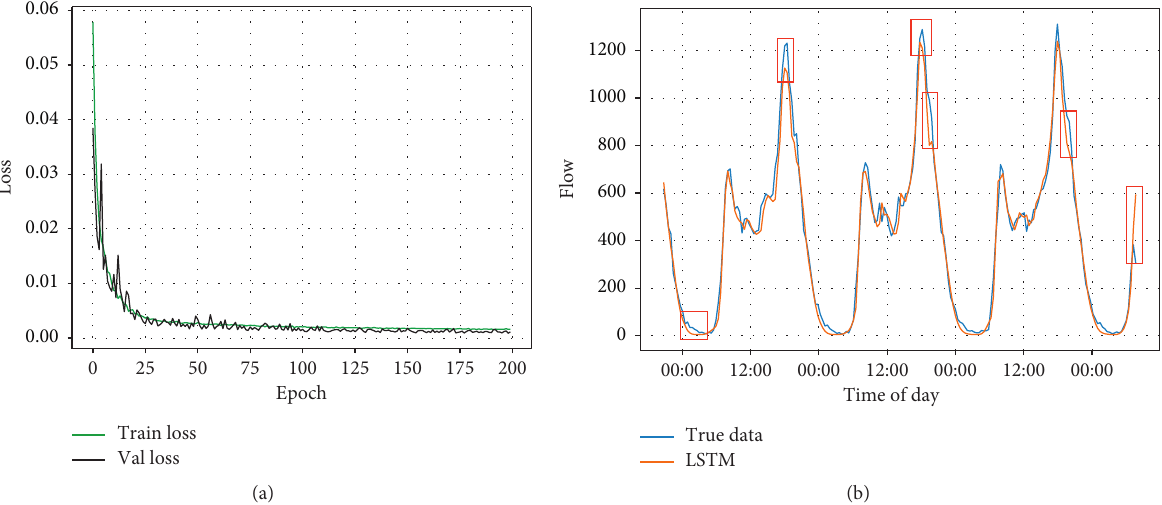
Figure 6: 25min LSTM training and prediction. (a) 25min LSTM loss function and (b) 25min LSTM prediction